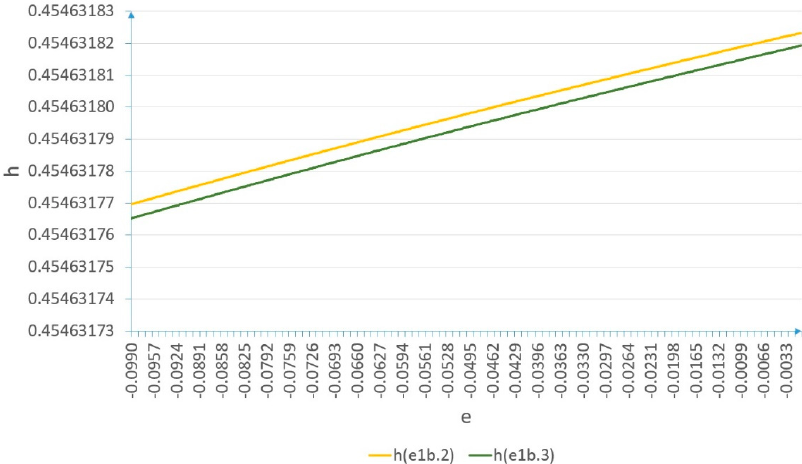
Figure 15. The result of the simulation of the h hypothesis value depending on the observation coefficients e1b.2 and e1b.3.